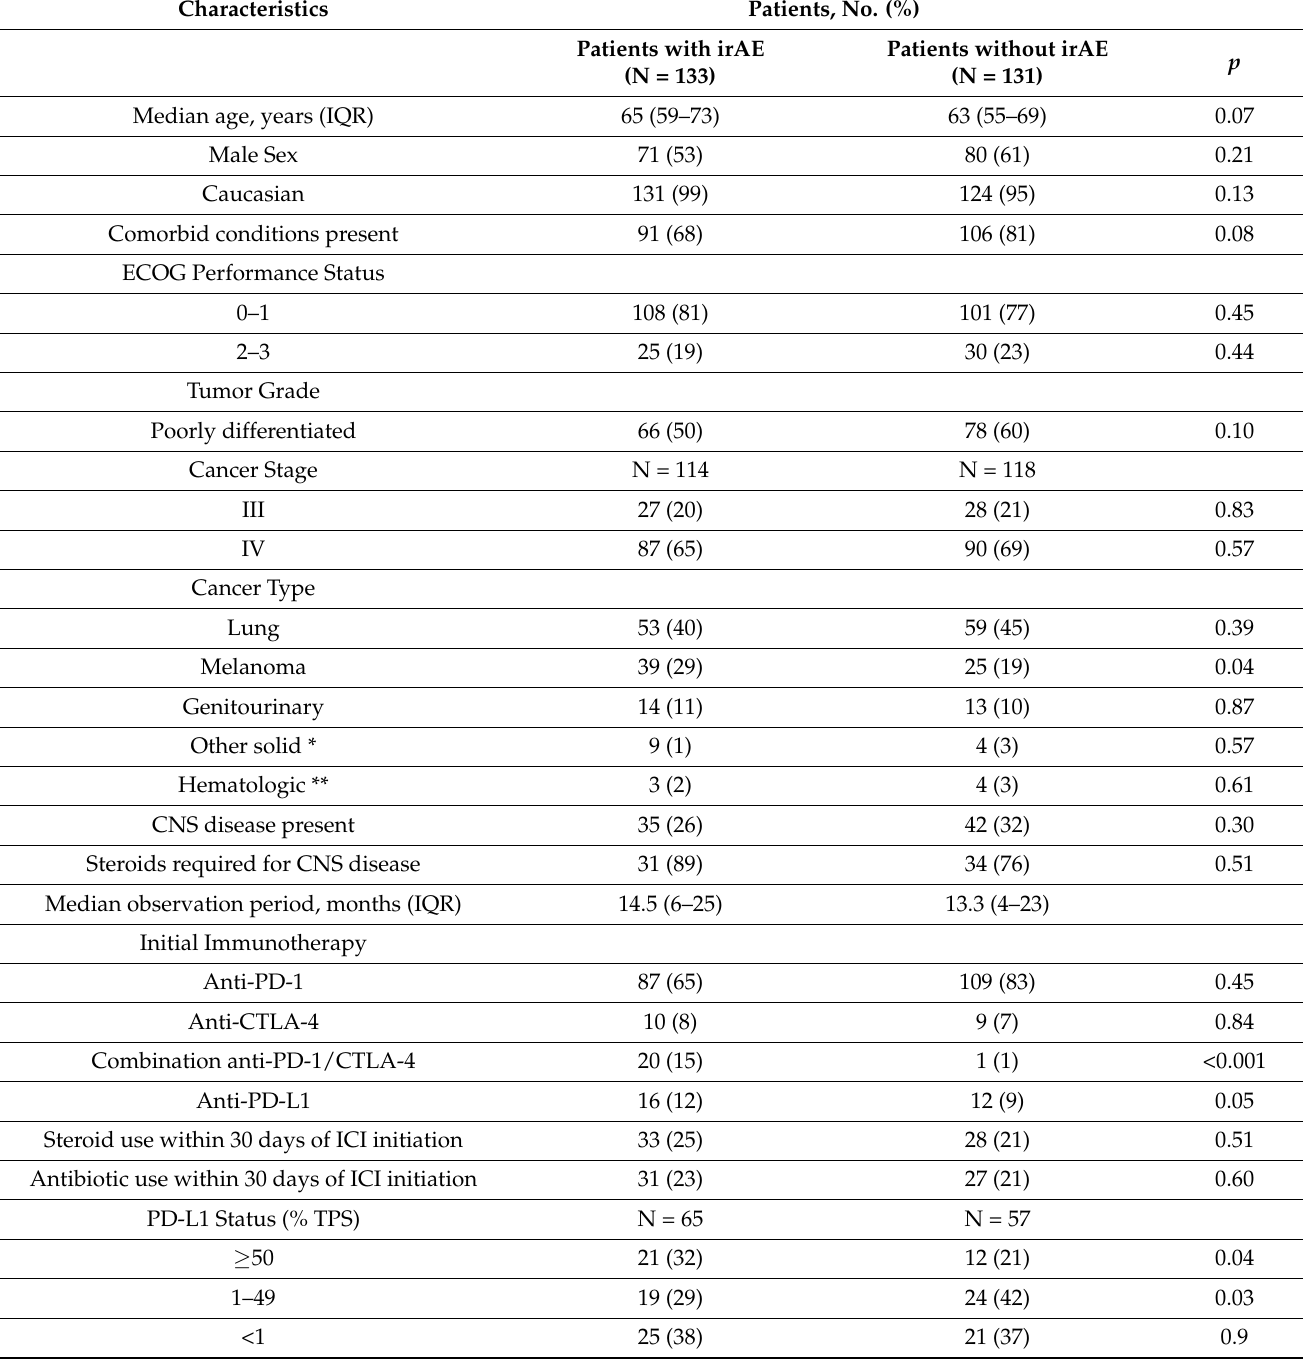
Table 1. General Characteristics of the Study Patients who had ICI Treatment With and Without